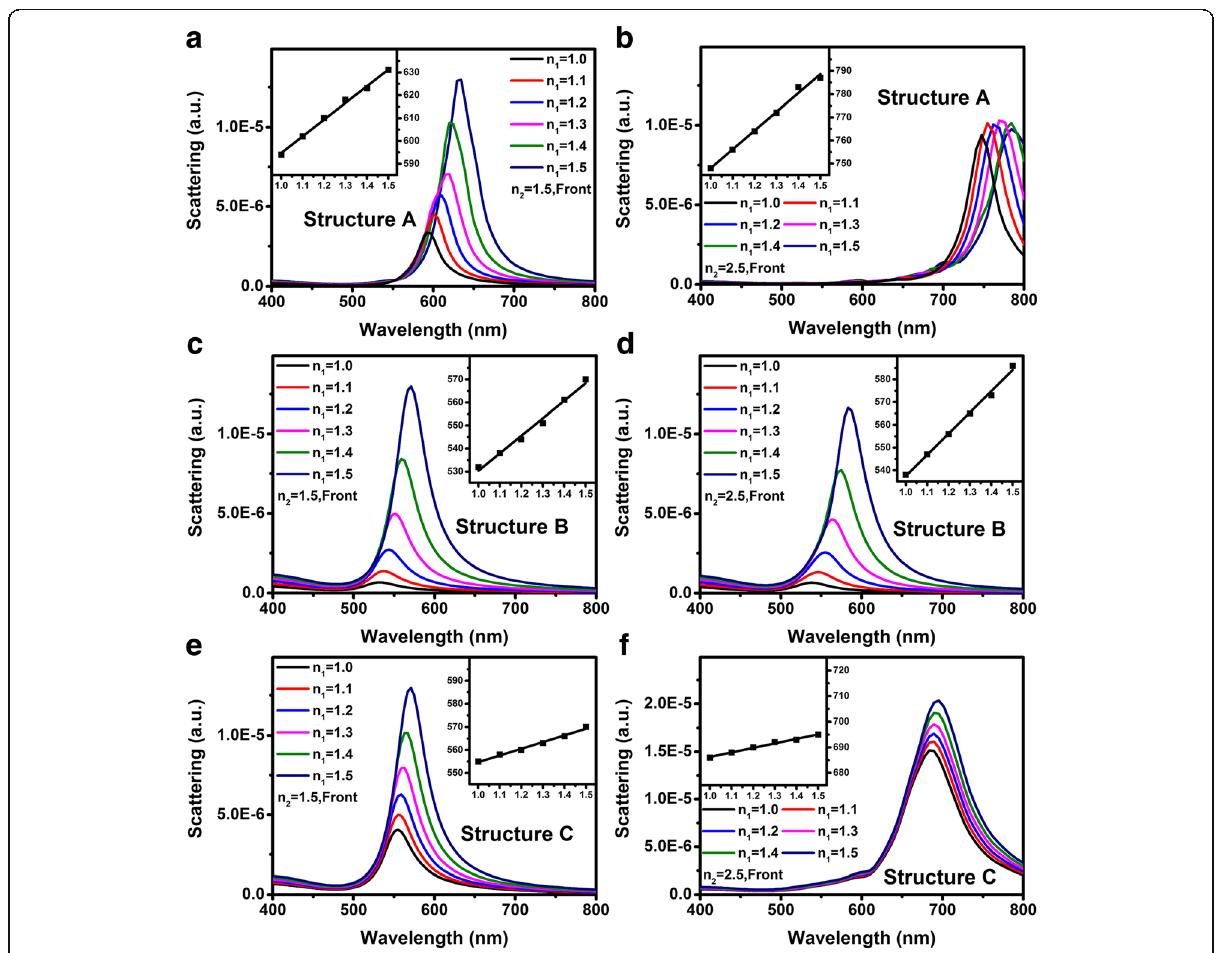
Fig. 3 a , c , e Scattering spectra of structure A to C when n 1 is linearly increased from 1.0 to 1.5. with fixed n 2 = 1.5, respectively. b , d , f Scattering spectra of structure A to C when